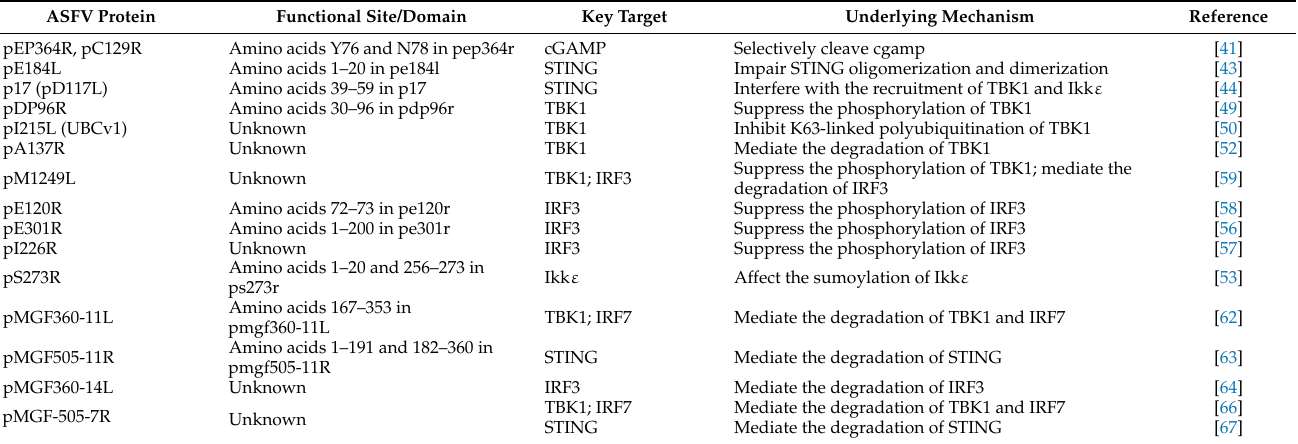
Table 1. Antagonisms of ASFV proteins in latest reports towards IFN-I production by targeting cGAS-STING